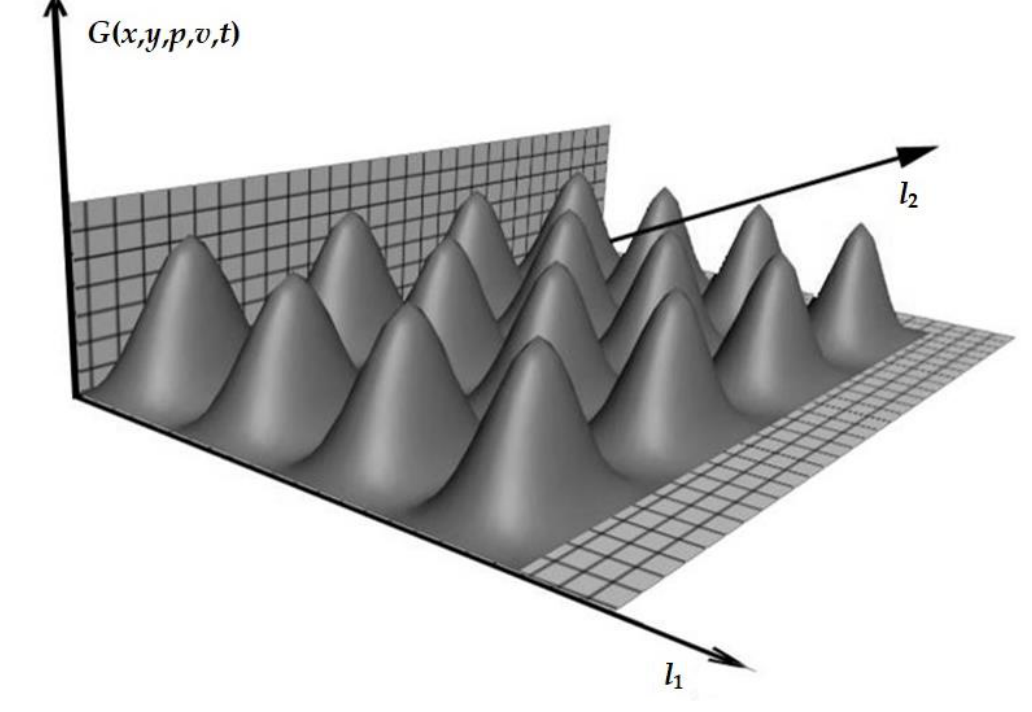
Figure 2. First heating pulse (the temperature and scale of the object are indicated in conventional units).